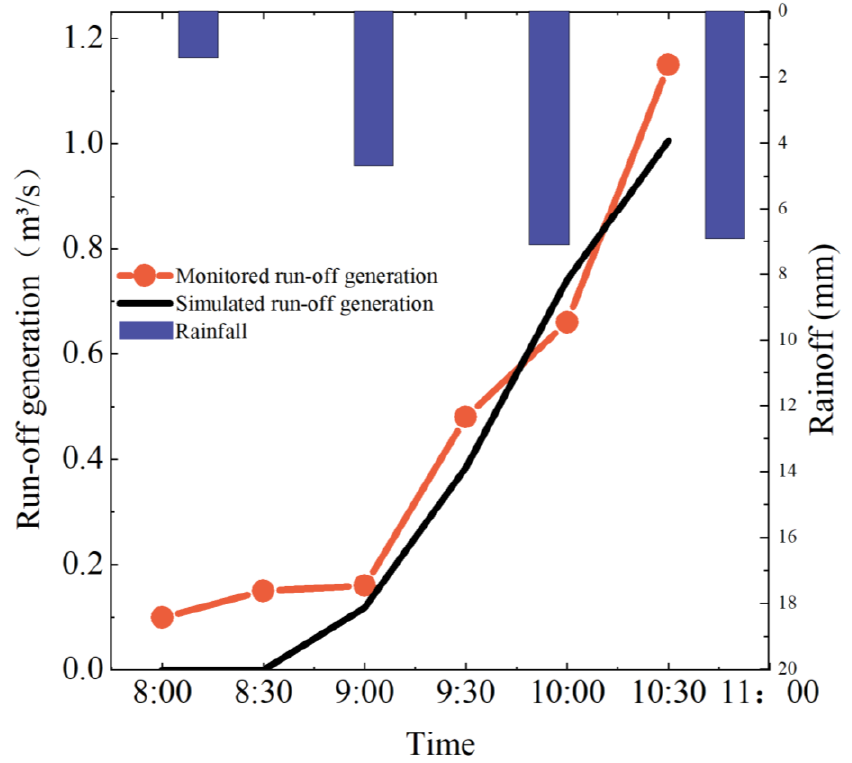
Figure 3. Checking chart on 12 July 2021.